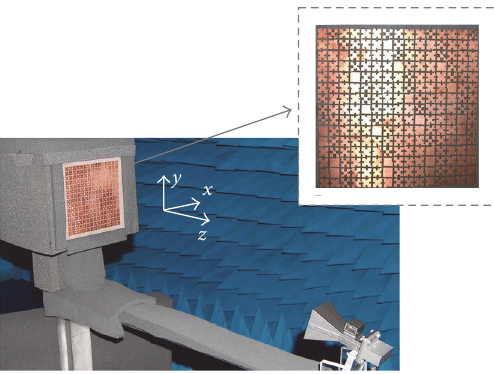
Figure 26: Photograph of the fabricated reflectarray prototype.